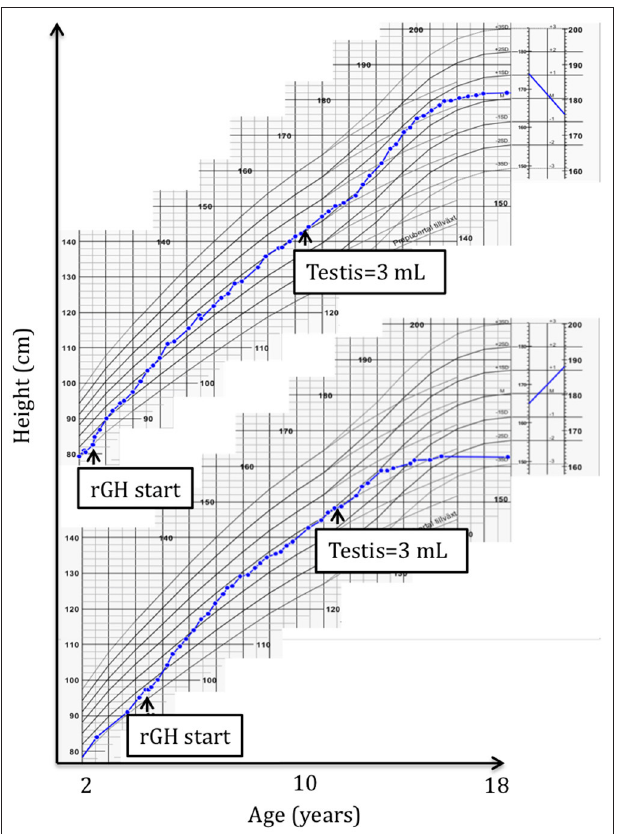
FIGURE 1 | A typical responder (R) height growth chart (top) compared to a typical non-responder (NR) height growth chart (bottom) ( 15). Start of recombinant growth hormone (rGH) treatment and pubertal onset are pointed